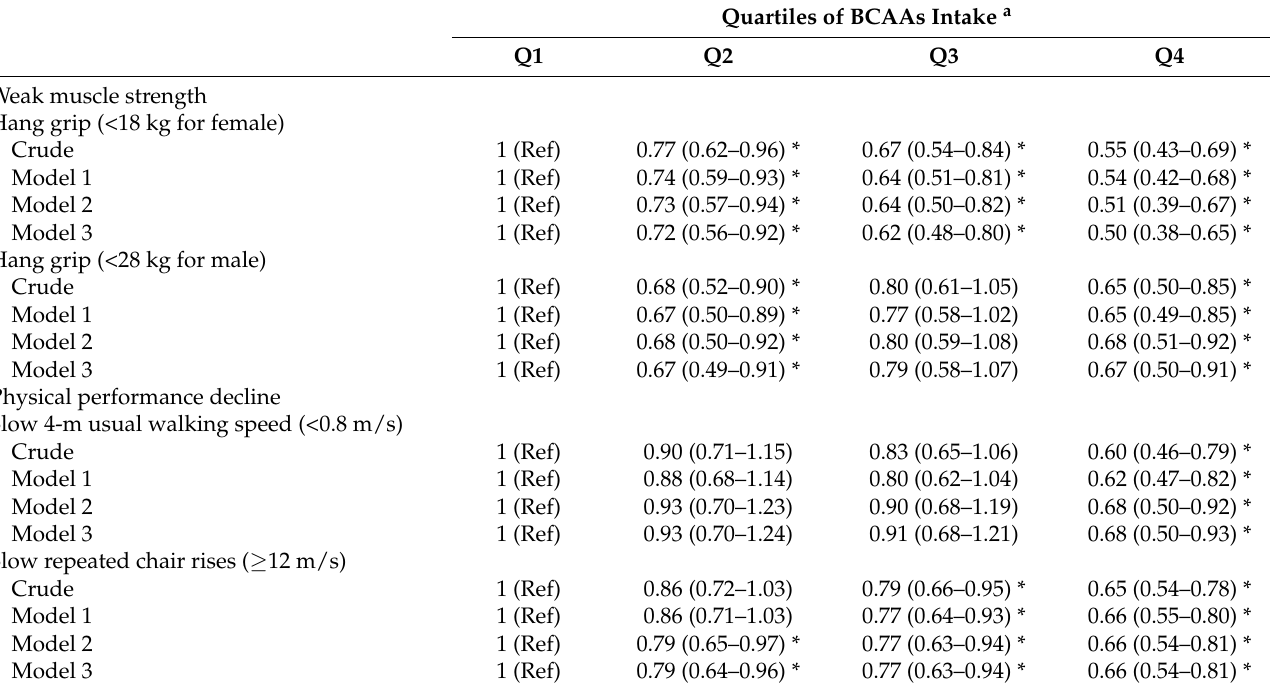
Table 4. Odds ratios of weak muscle strength or decline in physical function by quartiles of BCAAs intake. Quartiles of BCAAs Intake